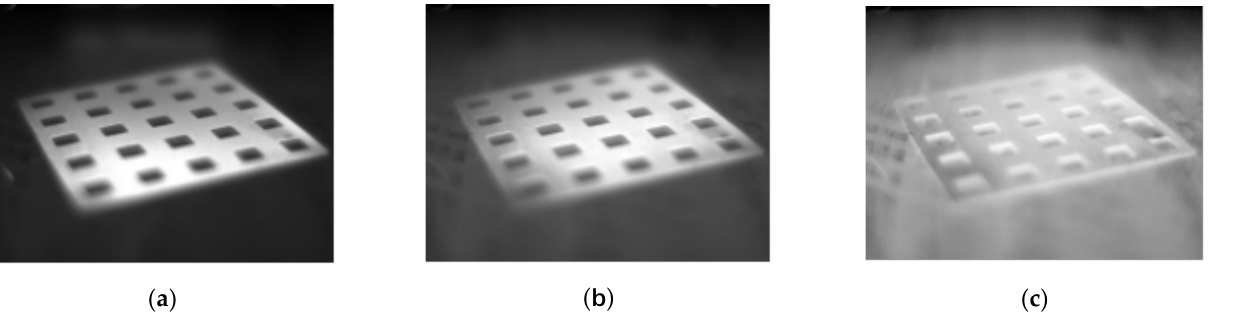
Figure 1. Thermal images of the calibration board with thermal diffusion. ( a ) Thermal image of the calibration board captured at time = 0 s. ( b ) Thermal image of the calibration board captured at time = 0.2 s. ( c ) Thermal image of the calibration board captured at time = 0.4 s.